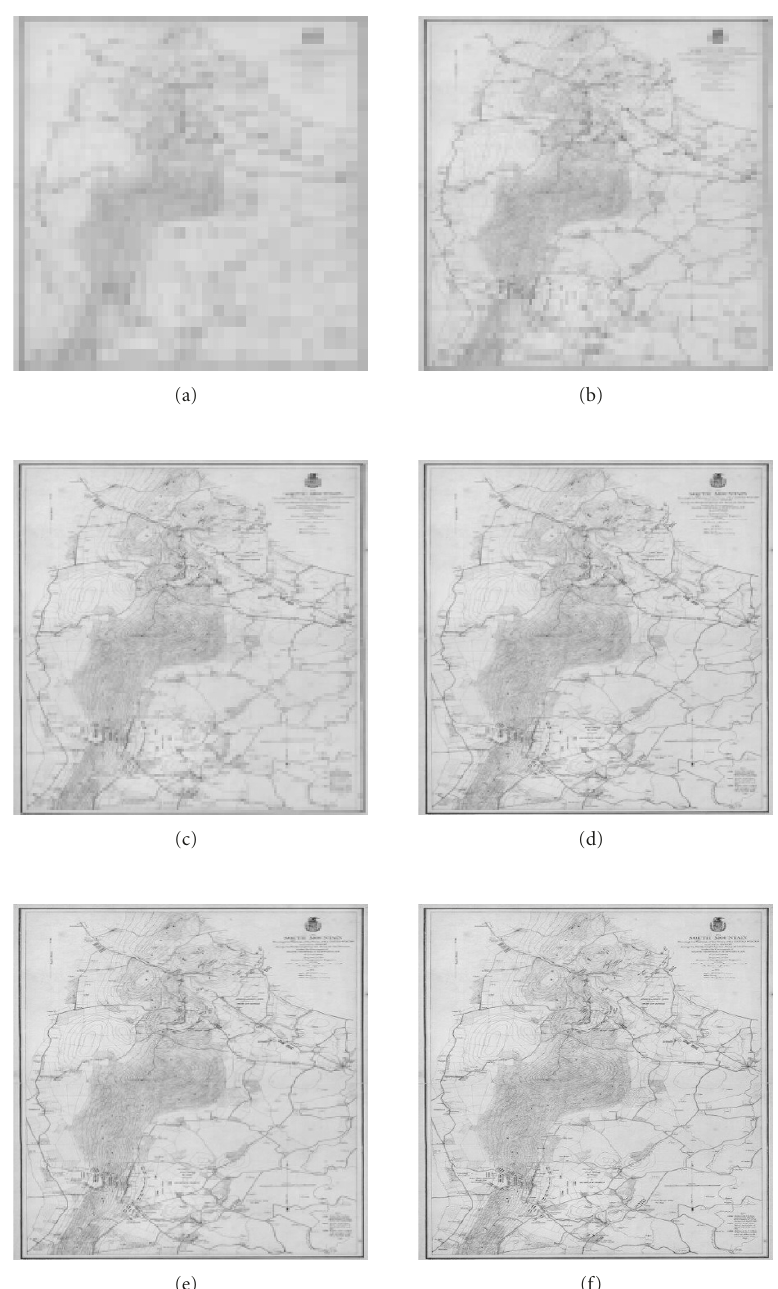
Figure 13: Progressive reconstruction of Military Map2 using any 4 out of 6 shadows and with the following percentages of coe ffi cients, and the resulting PSNR: (a) 1%, 22 . 19dB, (b) 5%, 23 . 48dB, (c) 15%, 24 . 85dB, (d) 25%, 28 . 09dB, (e) 50%, 31 . 21dB, (f) 100%,